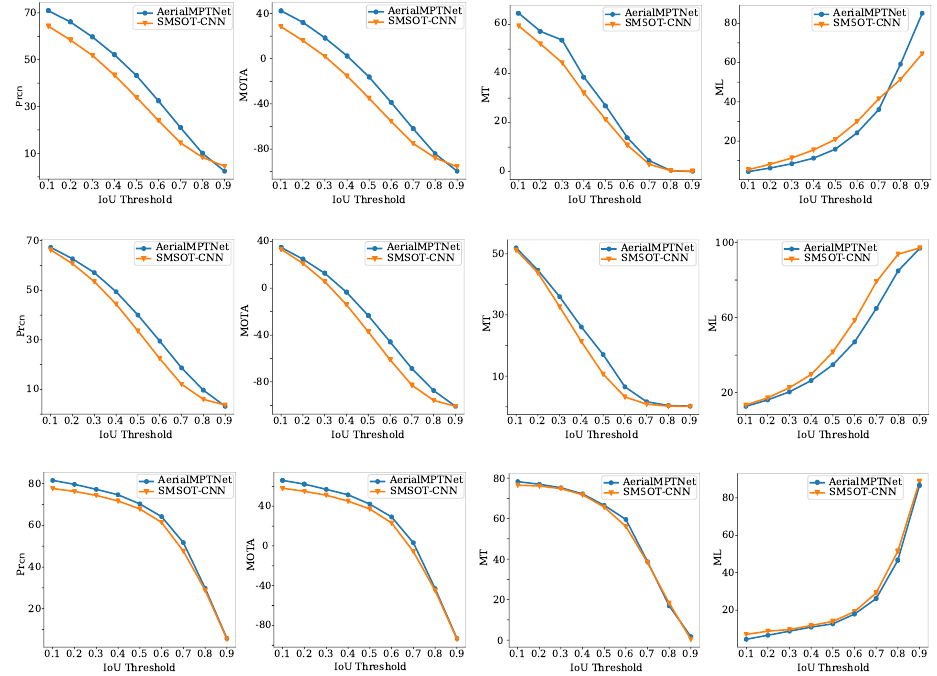
Figure 22. Comparing the Prcn, MOTA, MT, and ML of the AerialMPTNet and SMSOT-CNN on the KIT AIS pedestrian ( first row ), AerialMPT ( second row ), and KIT AIS vehicle ( third row ) datasets by changing the IoU thresholds of the evaluation